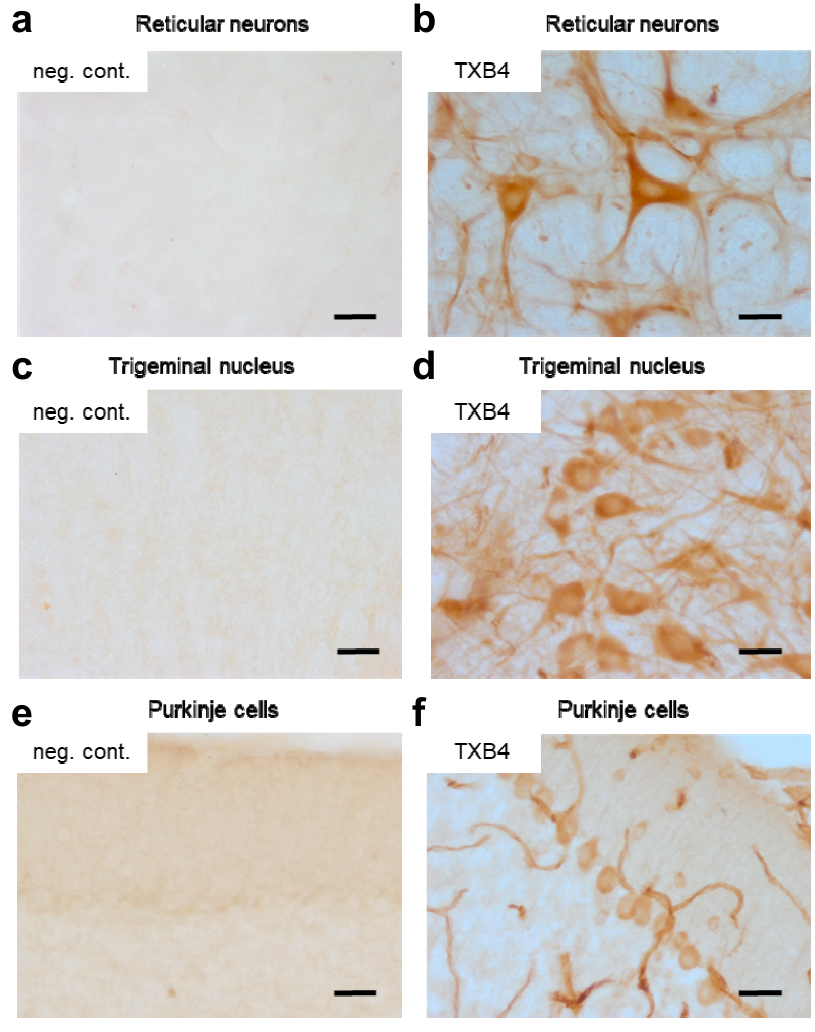
Figure 3. IHC assessment of brain penetration by the TXB4 shuttle. Mice were dosed with either TXB4 or negative control VNAR-hFc (neg. cont.) at 25 nmol/kg (1.875 mg/kg), IV and brains were collected following cardiac perfusion 18 h post injection ( n = 2). Brain sections were analyzed for the presence of exogenous antibodies by IHC and images were collected from representative regions for comparison. Sections taken from the thalamus showed the distribution of ( a ) the negative control versus ( b ) TXB4 with localization in reticular neurons. Pronounced TXB4 staining was seen in trigeminal neurons in the midbrain ( d ) and Purkinje cells in cerebellum ( f ), where diffused parenchymal staining and BCEC staining were clearly distinguishable; the negative control showed no staining in corresponding sections ( c , e ). Scale bars at 50 μ m.